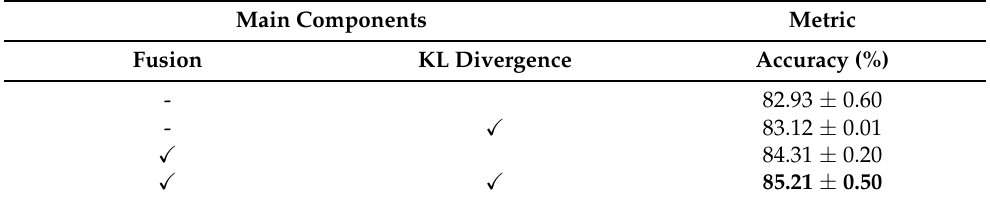
Table 2. Ablation study on Chinese multi-view patent data, “ (cid:88) ” means RMDPC with the correspond- ing component, “-” means “not